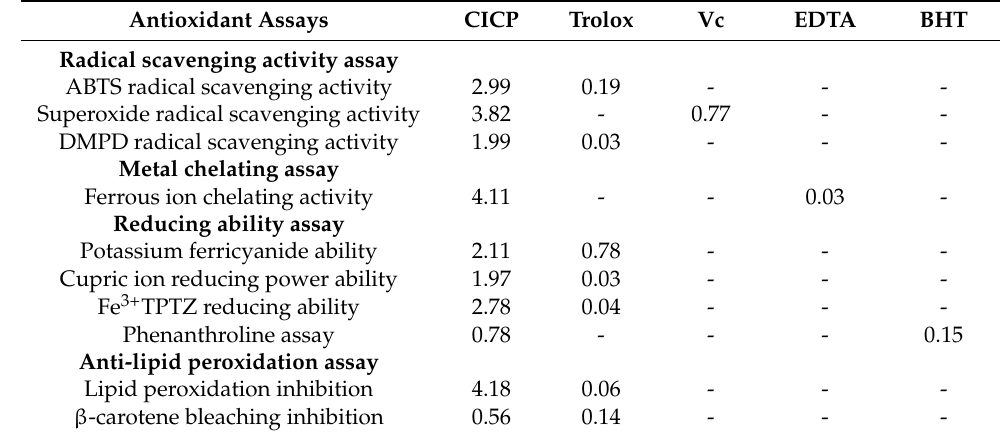
Figure 4. In vitro antioxidant assays of CICP. ABTS and superoxide radical scavenging activity ( A ); DMPD activity ( B ); FRAP and phenanthroline activity ( C ); CUPRAC activity ( D ); chelating ability ( E ); LPO and BCB inhibitory activity ( F ). Results were expressed as mean ± SD ( n = 3). Mean values within each graph with different letters (a–e) show significant differences ( p < 0.05) between concentrations. Table 2. EC 50 (mg/mL) values of CICP and standard compounds in different antioxidant